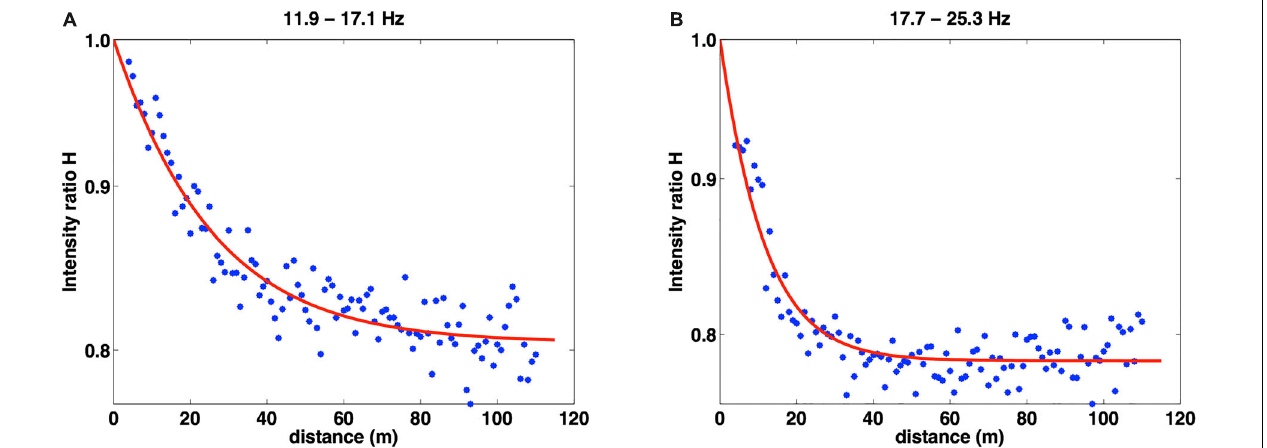
FIGURE 4 | Exponential fits evaluated in two different frequency bands for the whole grid. Results for frequency bands ranging from 11.9 to 17.1 Hz and from 17.7 to 25.3 Hz are shown in panels (A) and (B) , respectively.